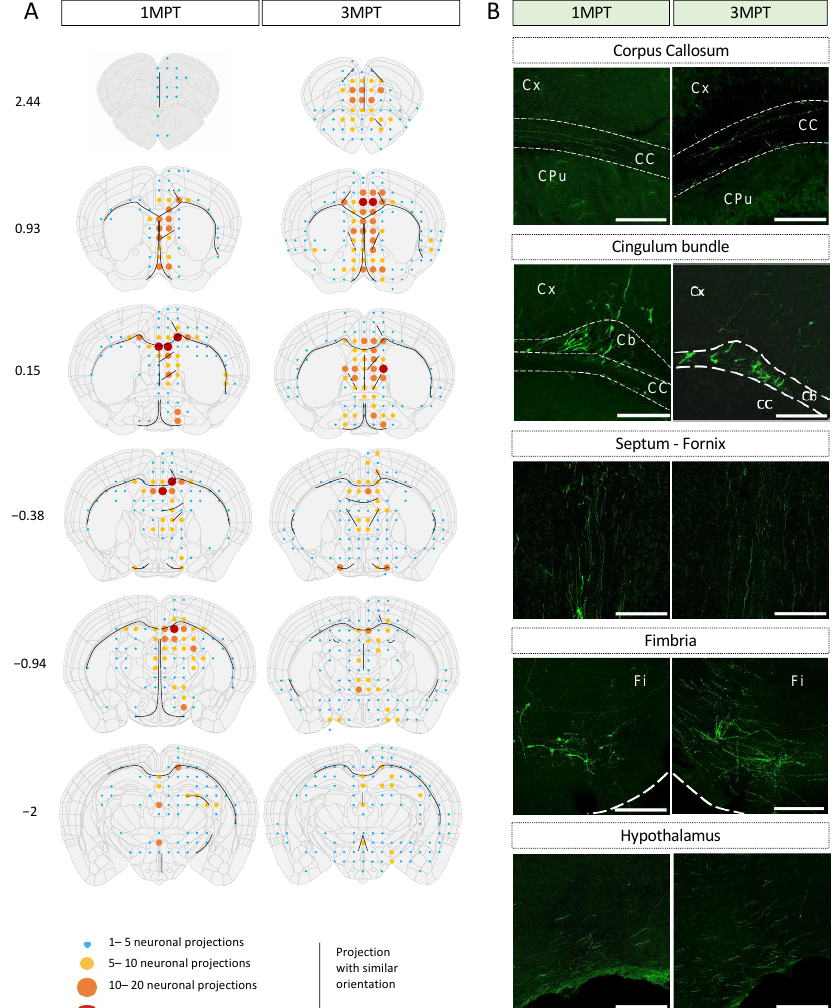
Figure 3. Mapping of neuronal projections from transplanted human cells within the LV of the embryonic mouse brain at 1 MPT and 3 MPT. ( A ) Camera lucida drawings are according to Allen Brain Atlas (https://mouse.brain-map.org/, accessed on 25 January 2023). Image credit: Allen Institute. The densities of neuronal projections are depicted using a code-color schematic representation. Results are calculated as the mean value from three independent mice. Two to three brain sections were analyzed for each coordinate (Bregma, indicated in mm) and per mouse. ( B ) Representative images of GFP+ projections at 1 MPT and 3 MPT in fiber tracks and brain regions such as the cortex (Cx), corpus callosum (CC), cingulum bundle (Cb), septum/fornix, fimbria (Fi), and hypothalamic region. The illustrated data are from the three representative brains. Scale bars = 200 µm.